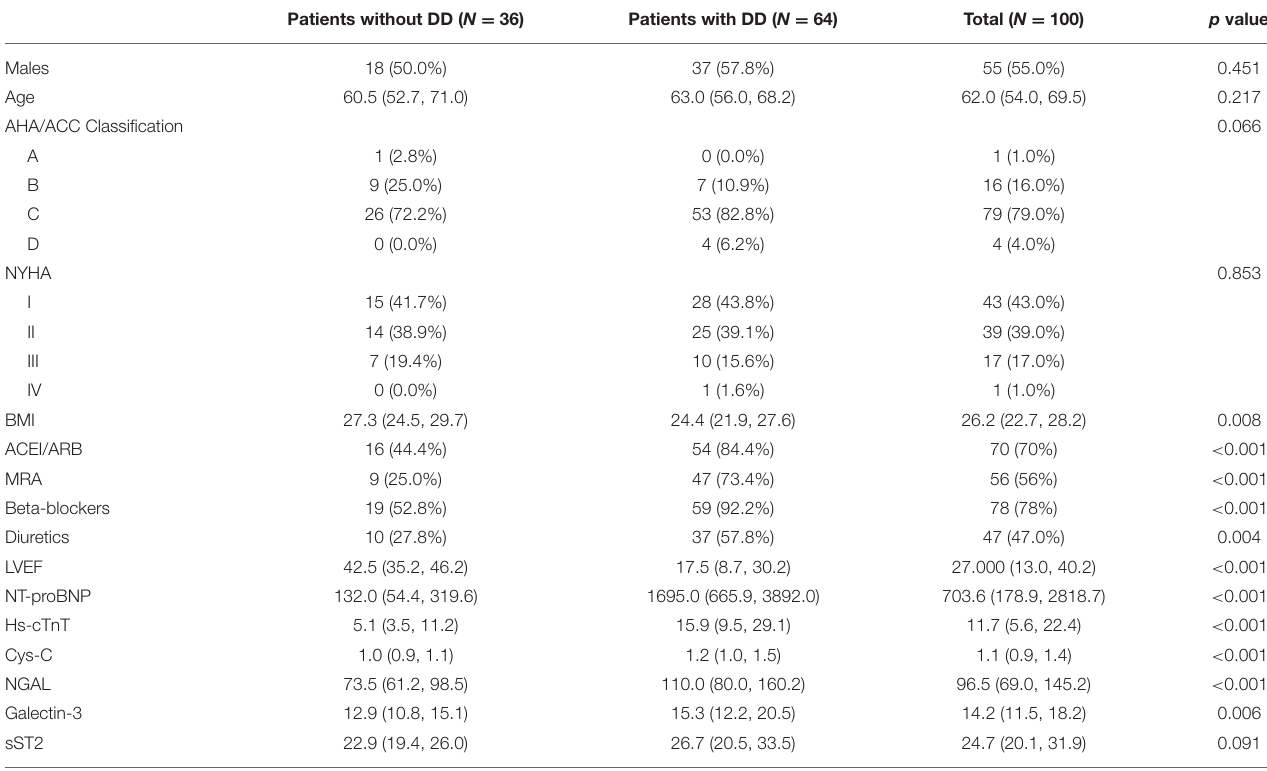
TABLE 1 | Characteristics of the patients with chronic Chagas cardiomyopathy evaluated according to diastolic dysfunction diagnosis ( n = 100).